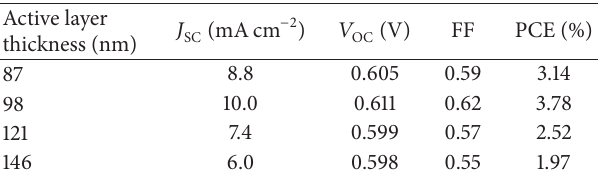
Table 1: The photovoltaic parameters of P3HT :PC ricated at different active layer